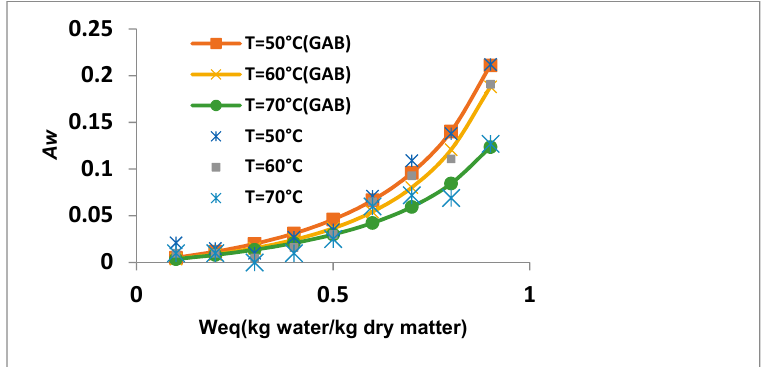
Figure 10. Experimental desorption isotherms for corn kernels at different temperatures and the results estimated with the GAB model.